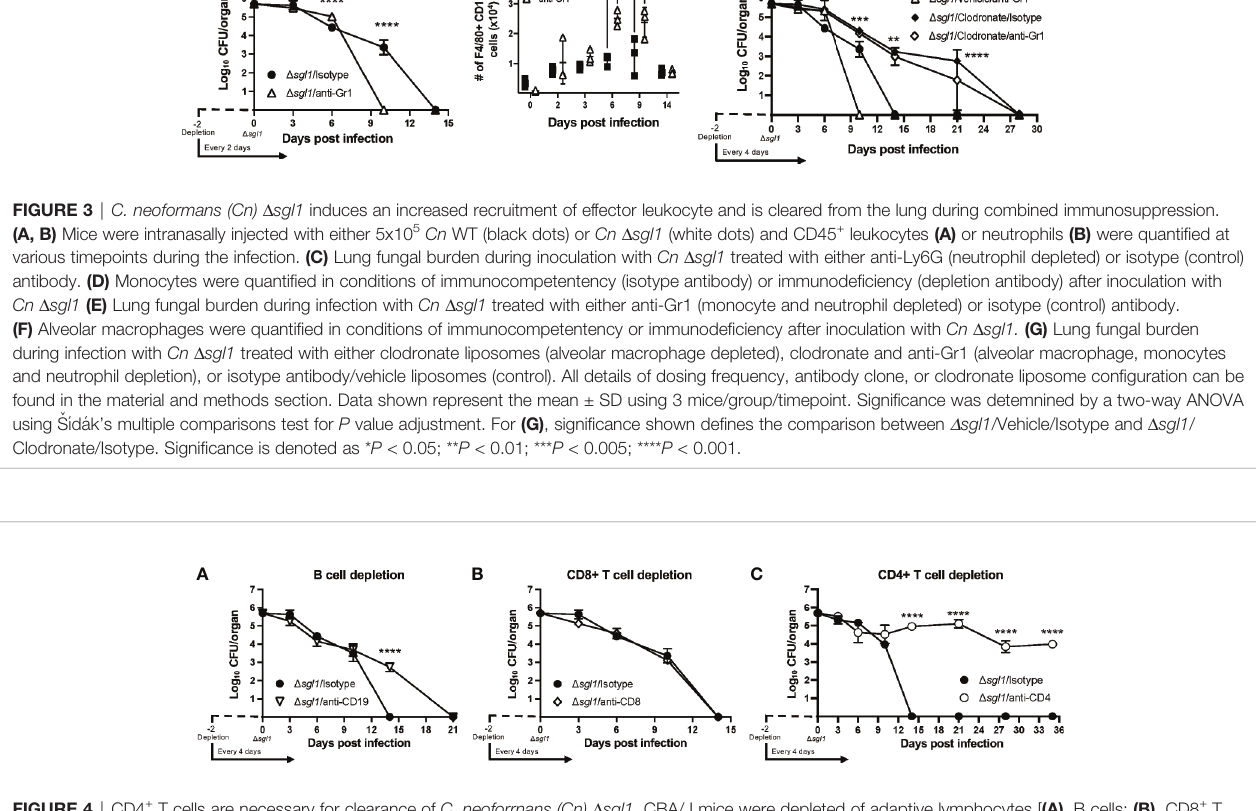
FIGURE 4 | CD4 + T cells are necessary for clearance of C. neoforrnans (Cn) D sgl1 . CBA/J mice were depleted of adaptive lymphocytes [ (A) , B cells; (B) , CD8 + T cells; (C) , CD4 + T cells] and lung fungal burden analysis was determined for each condition. Signi fi cance was detemnined using a two-way ANOVA using S ̌ ı ́ da ́ k ’ s multiple comparisons test for P value adjustment. All details of dosing frequency, antibody clone, or clodronate liposome con fi guration can be found in the material and methods section. Graphed data represents the mean +I -SD, and signi fi cance is denoted as **** P <